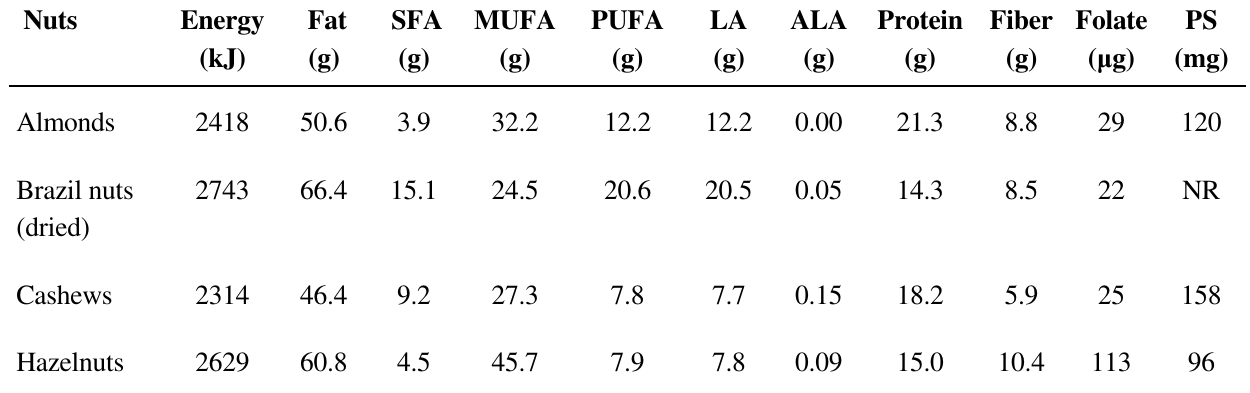
Table 1. Average nutrient composition of nuts (per 100